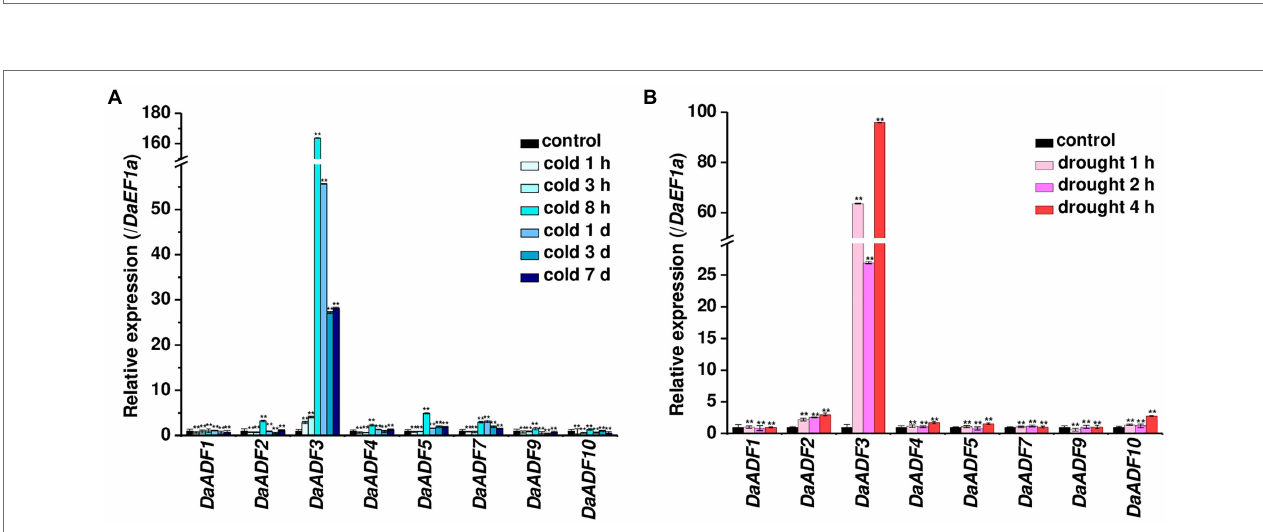
FIGURE 3 | Expression profiles of DaADF homologs in response to cold and drought. Laboratory-cultured 3-week-old D. antarctica seedlings were subjected to (A) cold (4 ° C for 7 days) and (B) drought (air-dried on filter paper at 15 ° C for 4 h) treatments, and total RNA prepared from the treated tissues was analyzed by RT- qPCR using gene-specific primer sets ( Supplementary Table 2 ). The relative expression level of each gene was normalized to that of DaEF1a . Data are means ± SD of three biologically independent experiments (** p < 0.01, Student’s t